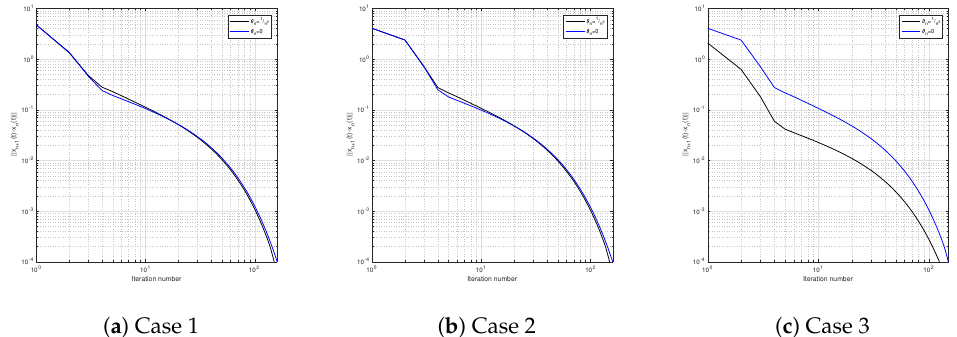
Figure 5. Cauchy error plots for the sequence { x n ( t ) } with and without the extrapolation factor ( θ n ) when (cid:36) n = 0.1.